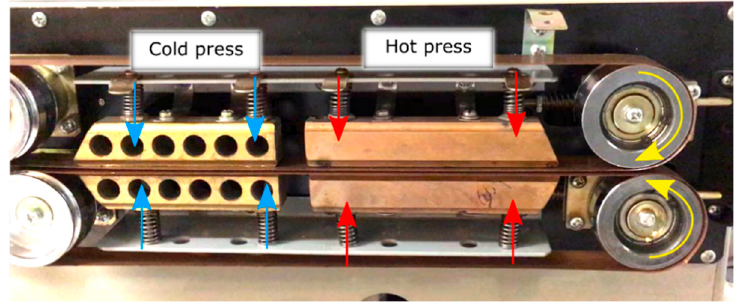
Figure 11. Pre-pregging module for consolidation of the fibres with the matrix.